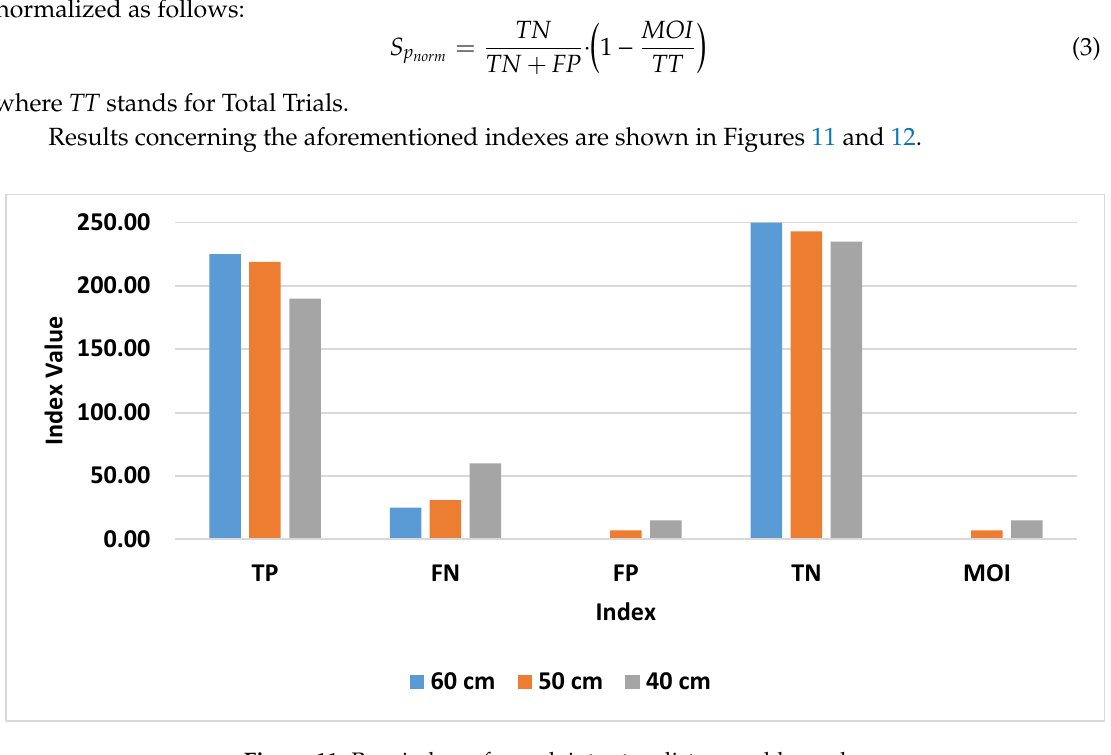
Figure 11. Raw indexes for each inter-tag distance addressed.